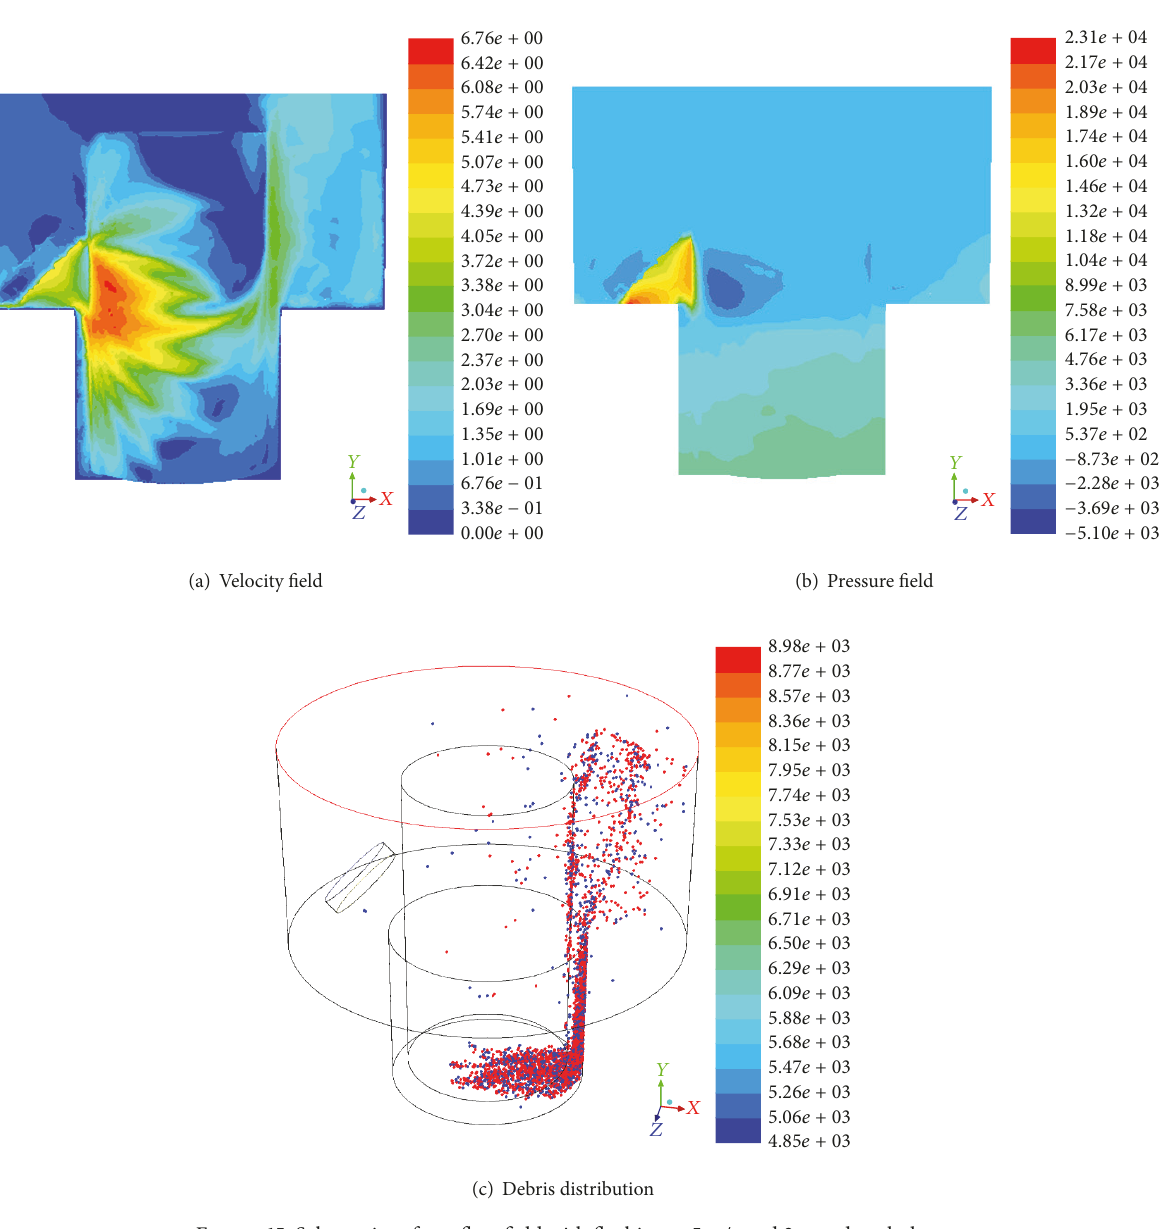
Figure 15: Schematics of gap flow field with flushing at 5m/s and 2 mm deep